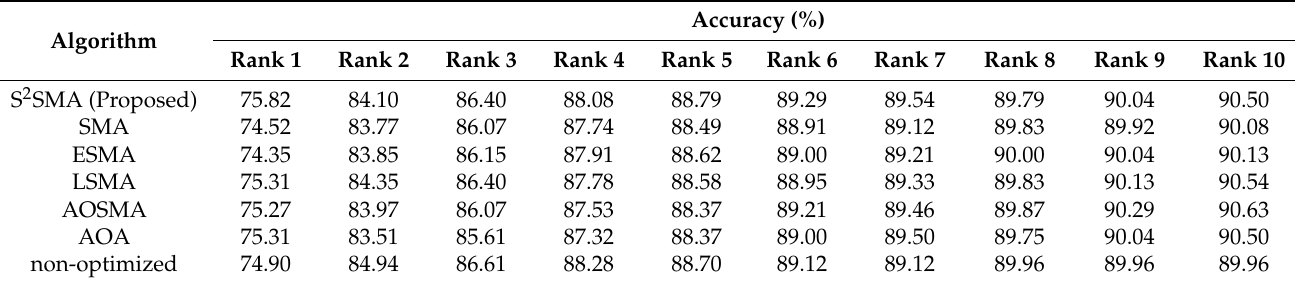
Table 12. Comparison of the effectiveness of several optimization model algorithms and the non- optimized model on